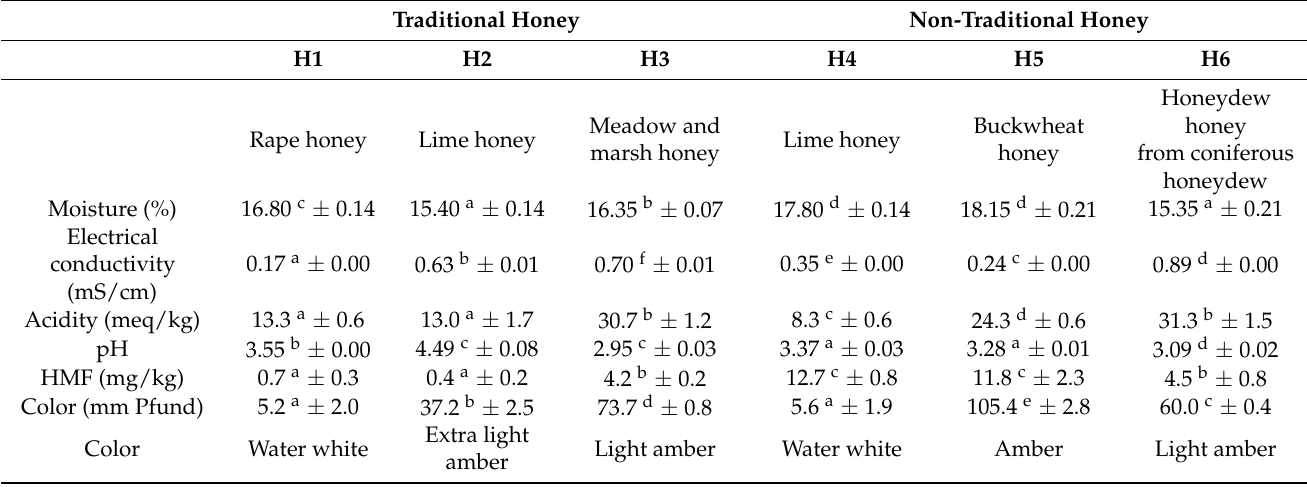
Table 1. Physicochemical parameters and color of honeys (average values and standard deviation). Traditional Honey Non-Traditional Honey H1 H2 H3 H4 H5 H6 Honeydew honey Buckwheat Meadow and Lime honey Rape honey Lime honey honey marsh honey from coniferous